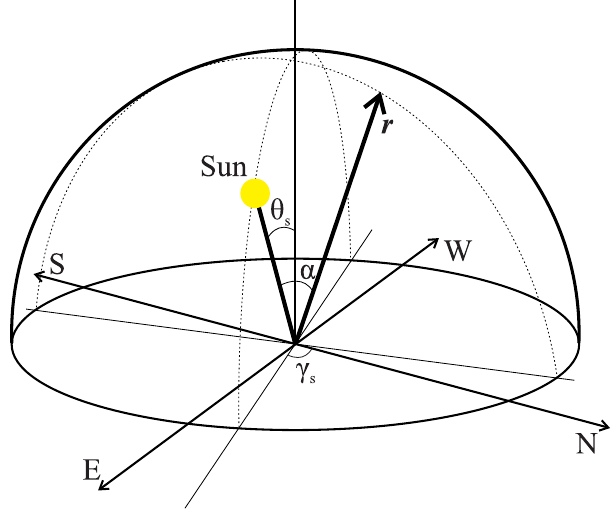
Figure 7. Diagram of the geometry used in the Rayleigh Sky Model. The vector r represents the viewing direction, γ s is the solar azimuth angle and α is the scattering angle. The observer is at the